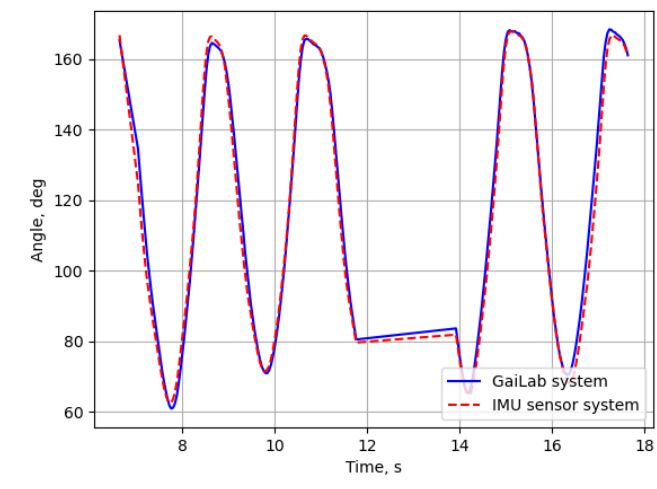
Figure 11. Comparison of knee angles during